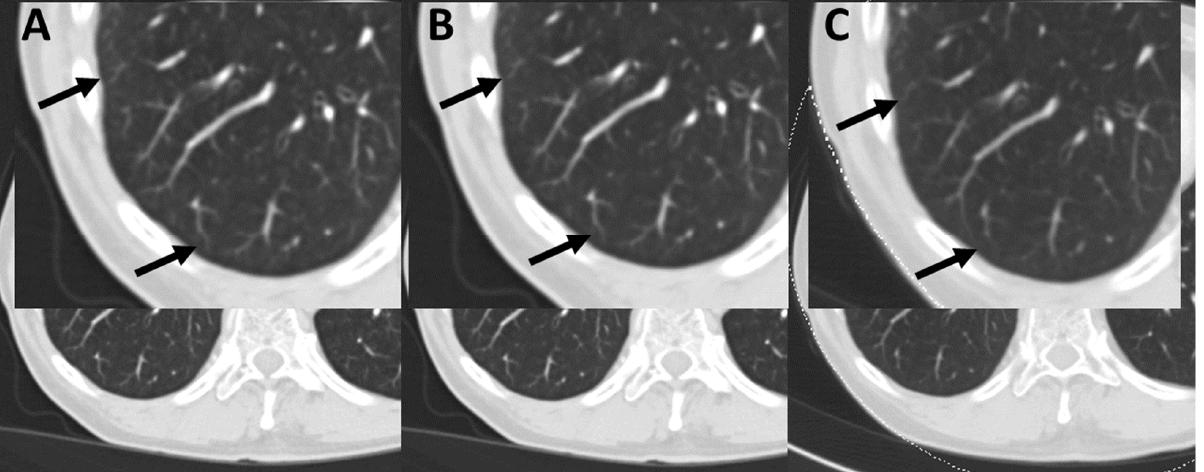
Figure 3. Delineation of lung vessel contours in a 59-year-old man. Window width: 1000 HU, Window level: − 590 HU, ( A ) Q1 iterative reconstructed image data set, ( B ) Q3 iterative reconstructed image data set, ( C ) ADMIRE1 iterative reconstructed image data set. Arrows: bifurcation of thin vessels.